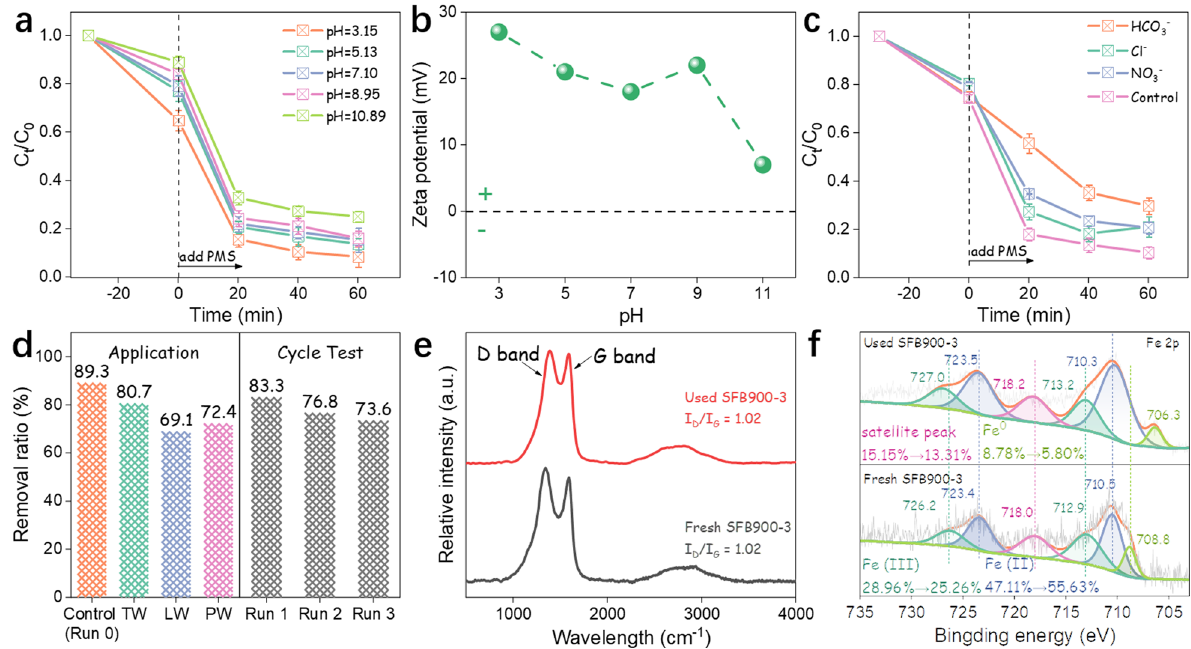
Fig. 7 a pH value effect on NTP removal by SFB900-3. b Zeta potential of SFB900-3 under different pH values. c Common coexistent ion influence on NTP removal by SFB900-3. d Application of SFB900-3 to remove NTP in different aquatic environments and its cycle test in the laboratory environment. The comparison of ( e ) Raman spectra and ( f ) XPS spectra of used and fresh SFB900-3. Conditions: [Biochar] L − 1 , [NTP] 40 mg L − 1 , [temperature] 25 °C, [initial pH] 5.87, [ions] 2 = = = =